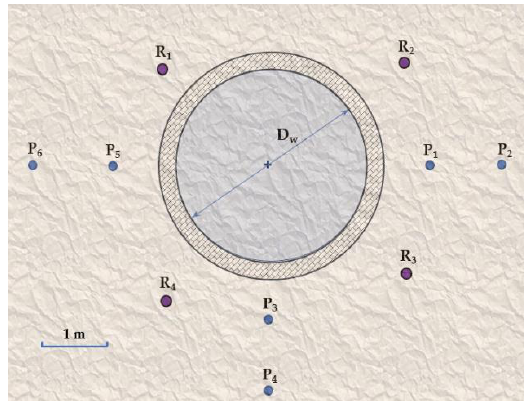
Figure 11. Pumping S-V well with the location of the observation boreholes, P i and R i.